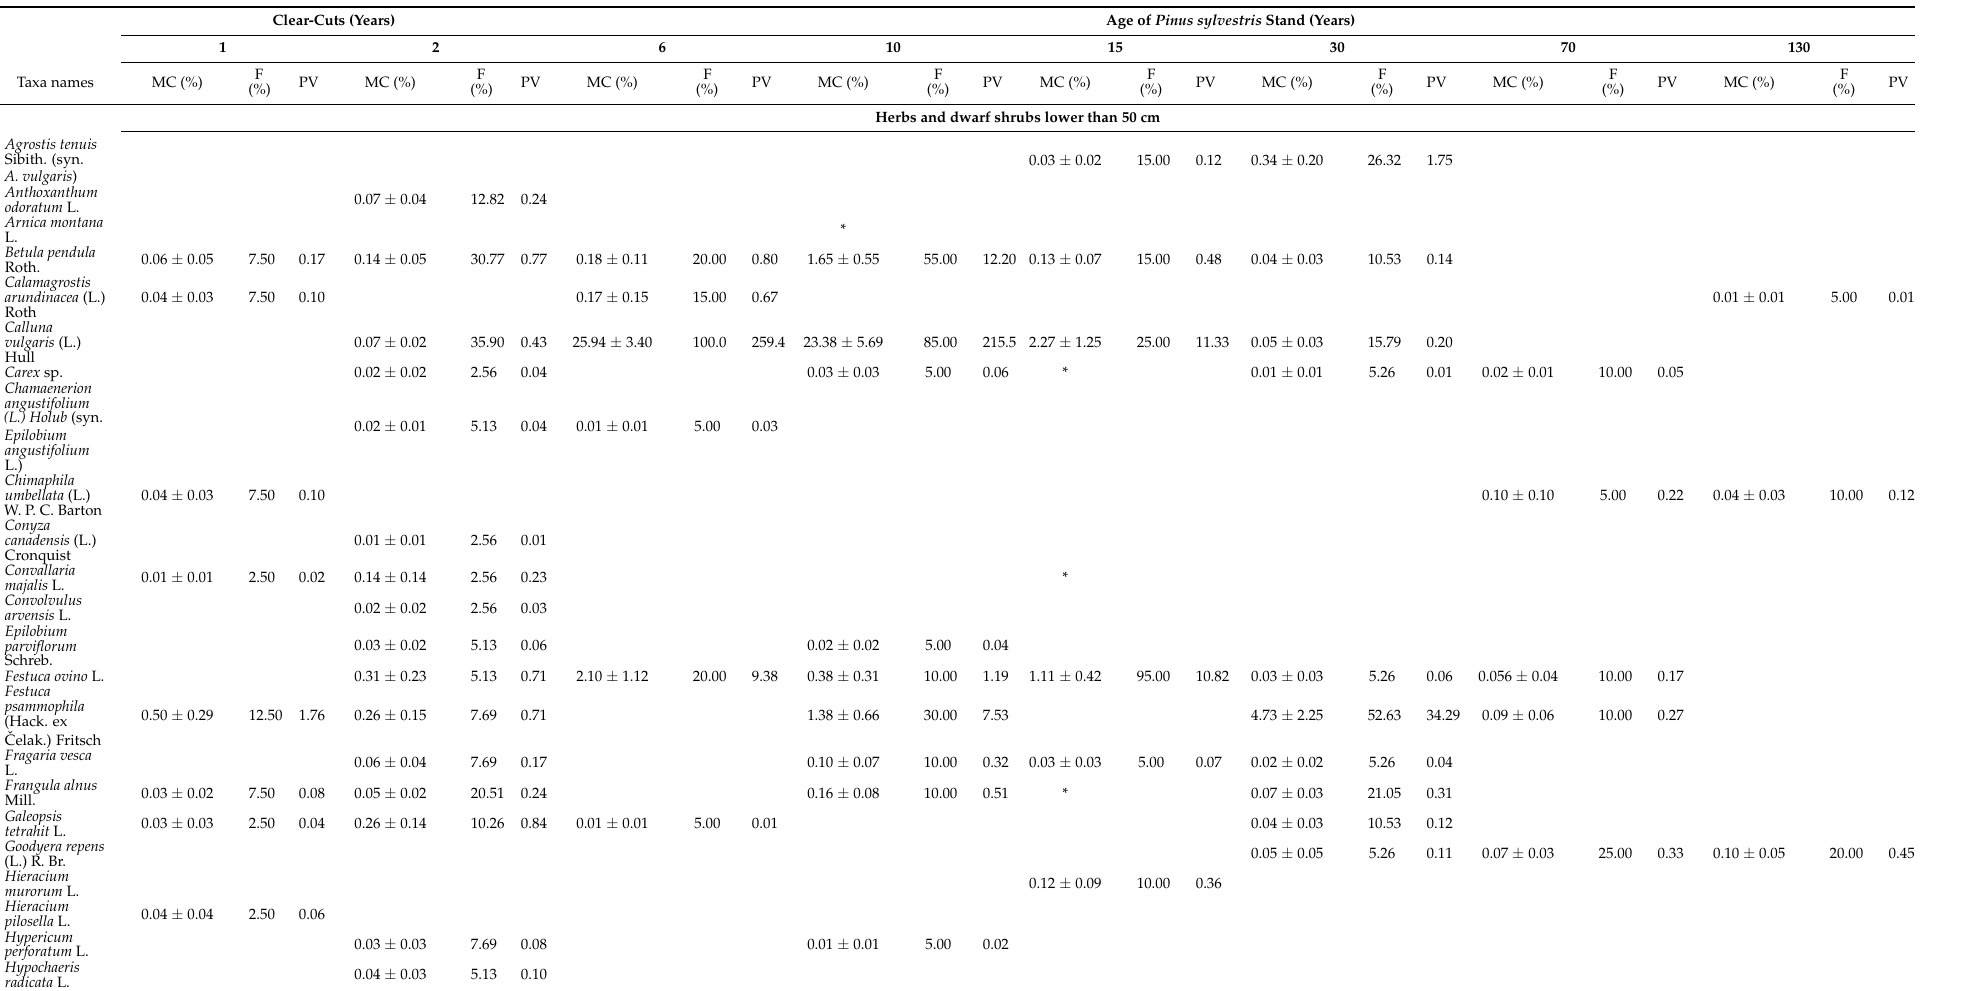
Table 1. Mean cover (MC, %) and frequency (F, %), and prominence value (PV) of ground vegetation species at different Pinus sylvestris sites, including 1–2-year-old clear-cuts and 6–130 years old